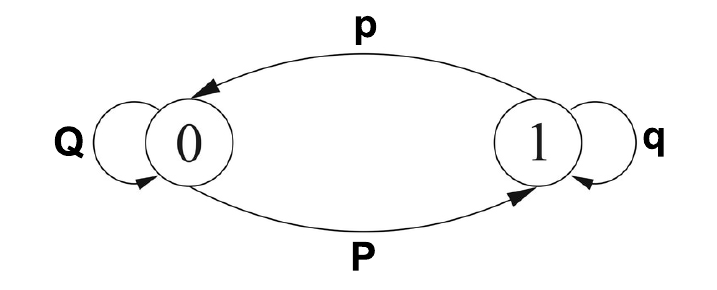
Figure 1. Gilbert model simulates burst-error with a two-state Markov chain (i.e., 0 and 1).